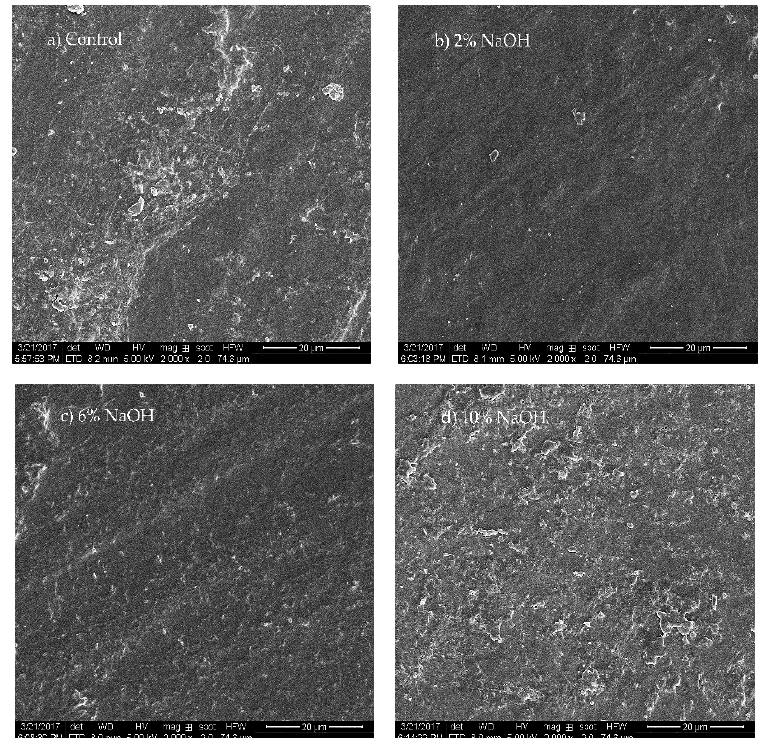
Figure 4. Surface morphology of HAS films treated with different concentrations of NaOH. ( a ) control; ( b ) 2% NaOH; ( c ) 6% NaOH; ( d ) 10% NaOH.